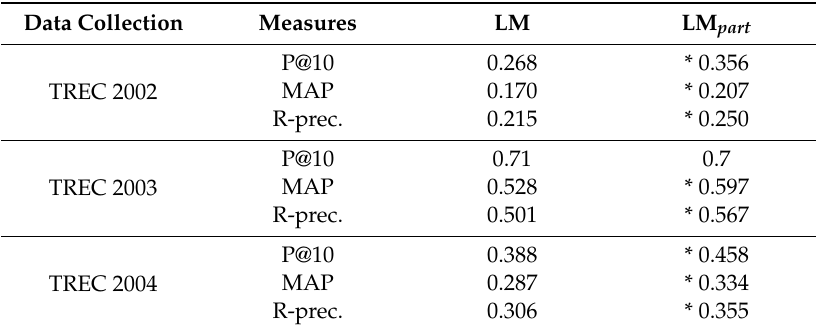
Table 5. Test results of methods LM and LM part ( µ = 100). Data